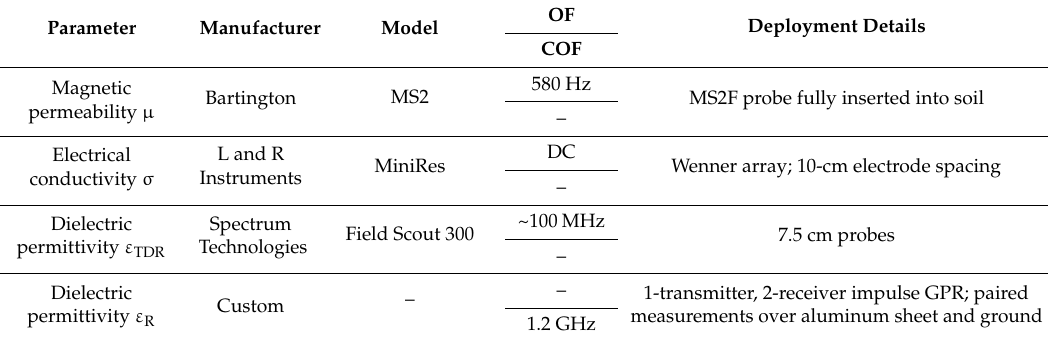
Table 2. Measuring